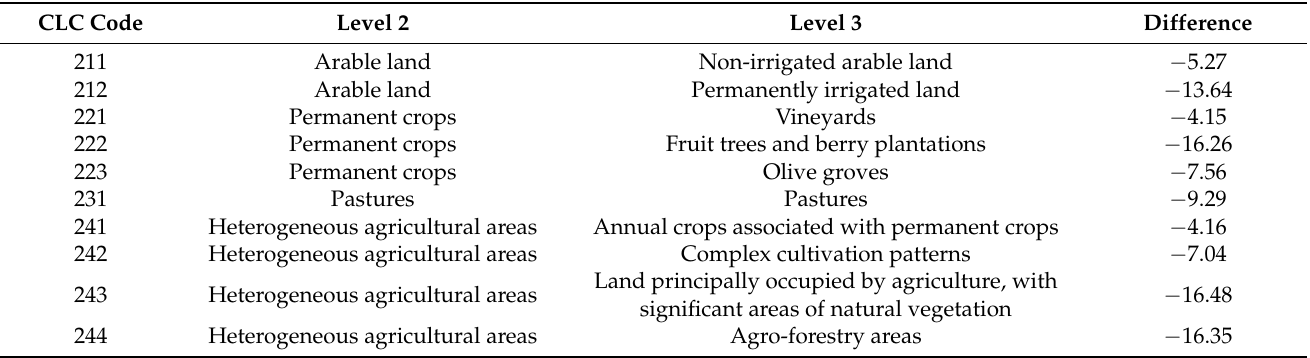
Table 6. Mean of percentage differences of soil loss estimation by water between the RUSLE ESDAC map 2016 and the elaborated 2014 map for CLC classes of agricultural